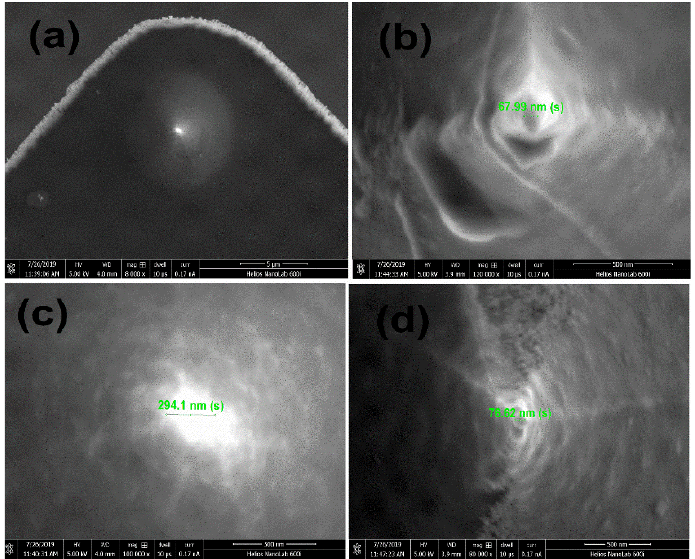
Figure 1. SEM image of a piezoresistive cantilever of magnetic film at the coated tip with different magnifications ( a ) 100 nm ( b ) 200 nm ( c ) 300 nm and ( d ) 500 nm. magnifications ( a ) 100 nm ( b ) 200 nm ( c ) 300 nm and ( d ) 500